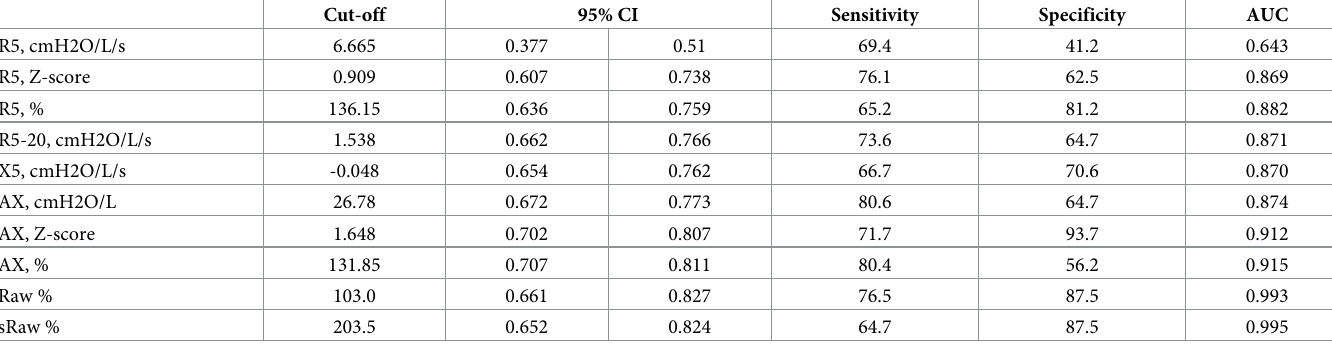
Table 4. Cut off, sensitivity, specificity, and their area under the curve with 95% CI of IOS and plethysmographic parameters for the diagnosis of BO.